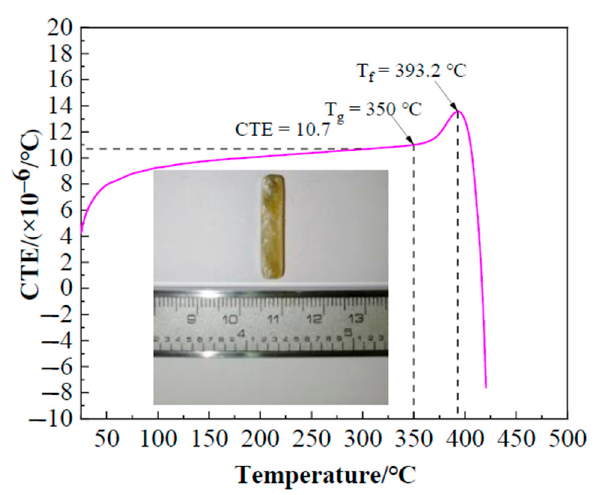
Figure 5. Coe ffi cient of thermal expansion (CTE) of the brazing filler glass as function of Figure 5. Coefficient of thermal expansion (CTE) of the brazing filler glass as function of temperature.